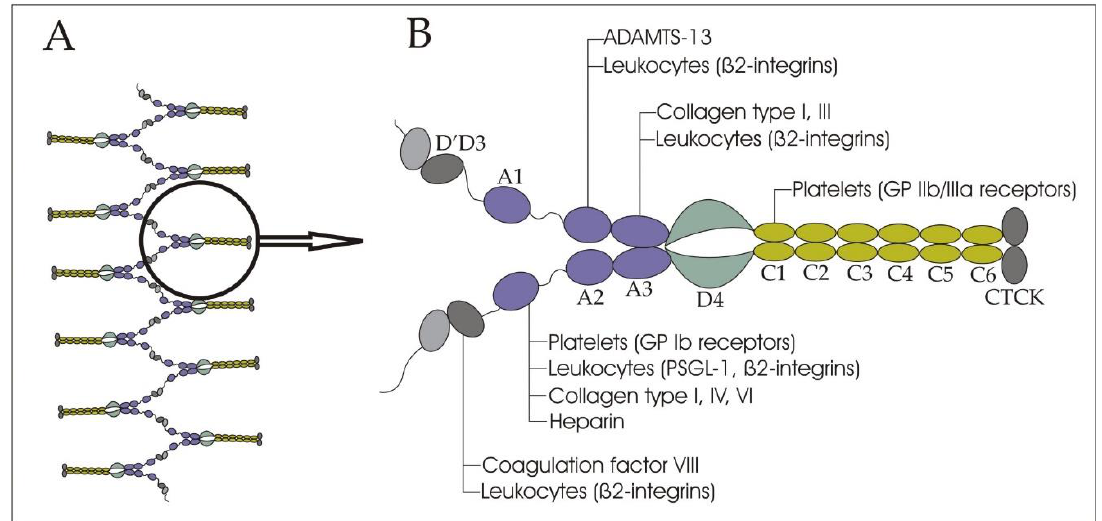
Figure 1. ( A ) A schematic representation of a von Willebrand factor thread; and ( B ) a von Willebrand factor dimer. The binding sites for ADAMTS-13, platelets, leukocytes, collagen, and heparin